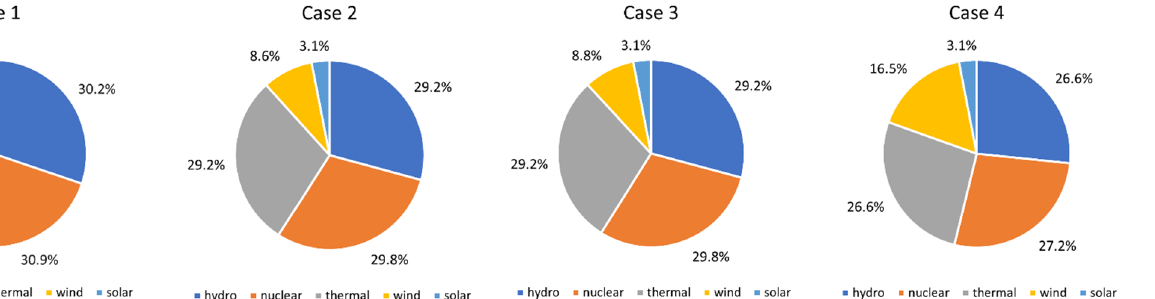
Figure 9. Energy profiles of each case.